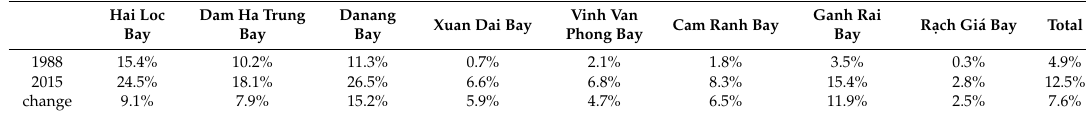
Table 7. Proportions of construction land in each bay.